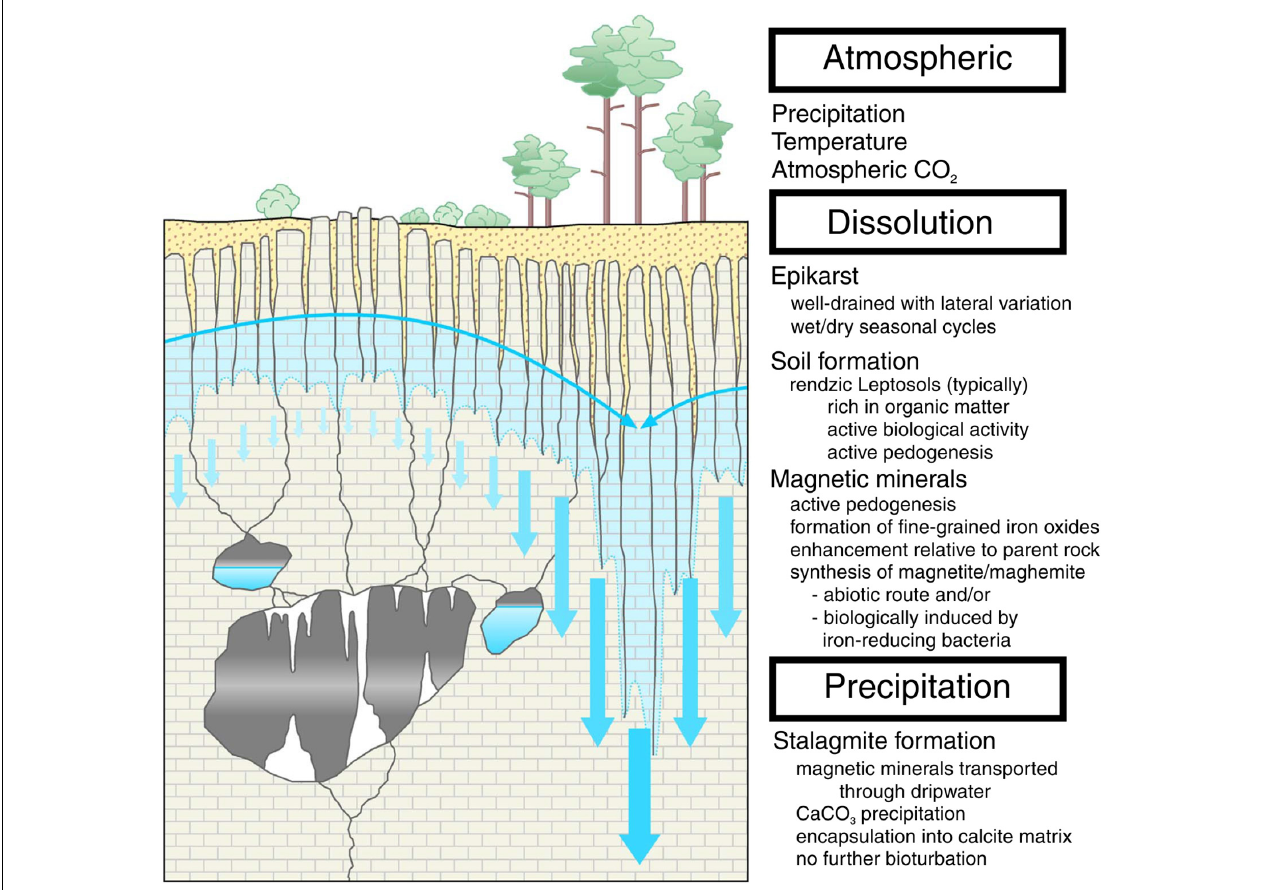
FIGURE 1 | Schematic description of the karst vadose zone (Hartmann and Baker, 2017), with processes that are related to the speleothem